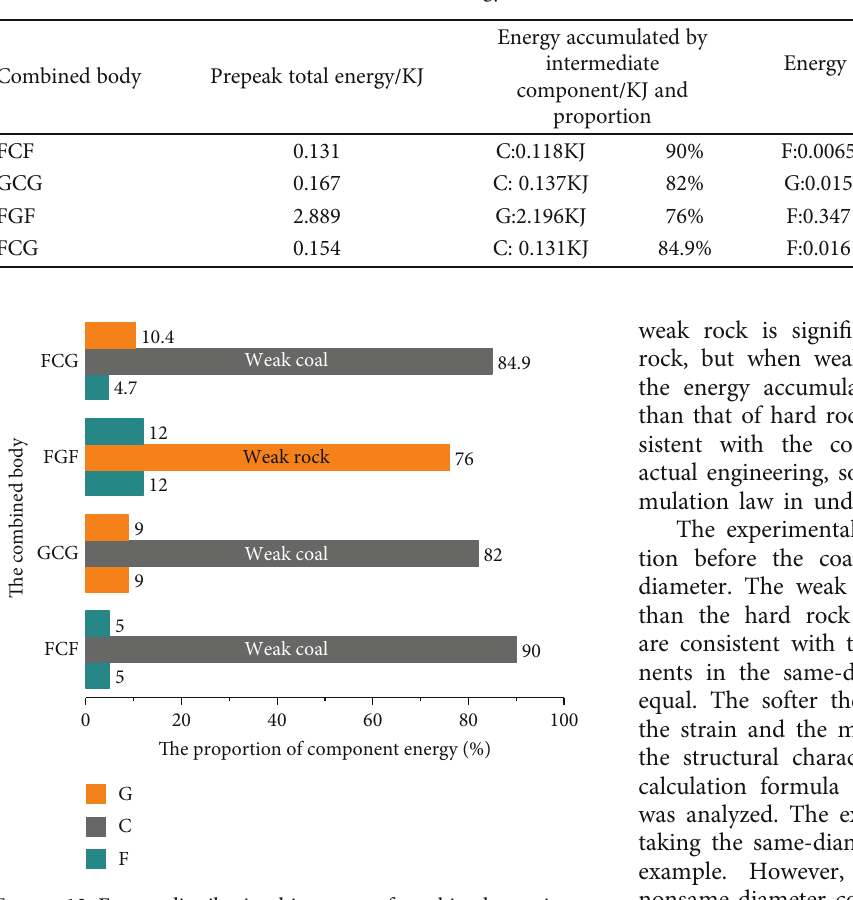
Table 4: The energy distribution of the four combined test pieces.